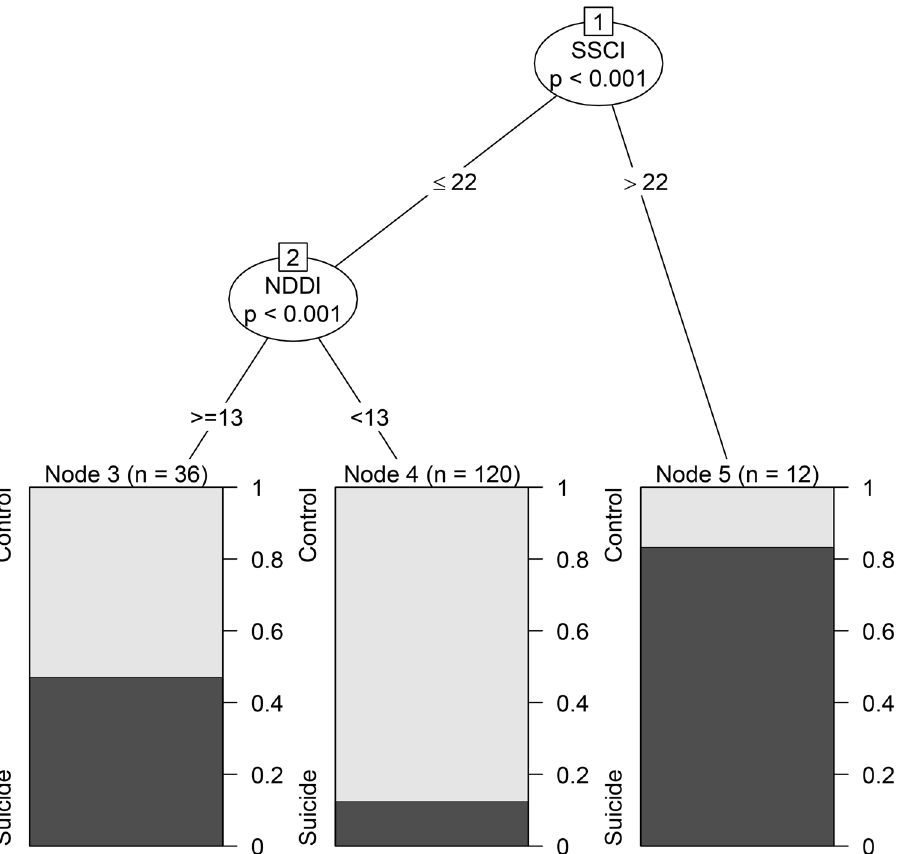
Figure 2. The Result of conditional inference tree: It shows the most significant factors were SSCI and NDDI(Using R × 64 3.5, www.r-proje ct.org); Two examples to show how to use it: Patient 1 got 20 scores in SSCI and 14 scores in NDDI, then he was divided into Node 3, which means he has about 48% possibility to have suicidal tendency. Patient 2 got 24 scores in SSCI, then he was divided in node 5, which means he has more than 80% possibility to have suicidal